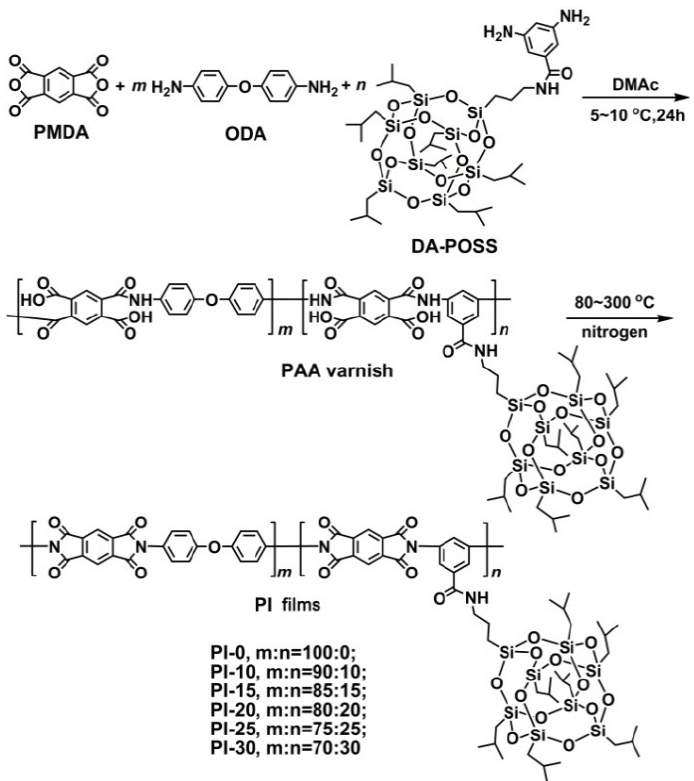
Figure 3. Synthesis of polyimides (PIs) and PI-ref films. Table 1. Inherent viscosities and molecular weights of poly (amic acid)s (PAAs).